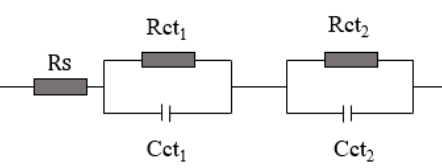
Figure 11. Nyquist plots of the DSSCs with quasi-solid-state electrolytes and ionic liquid electrolytes.